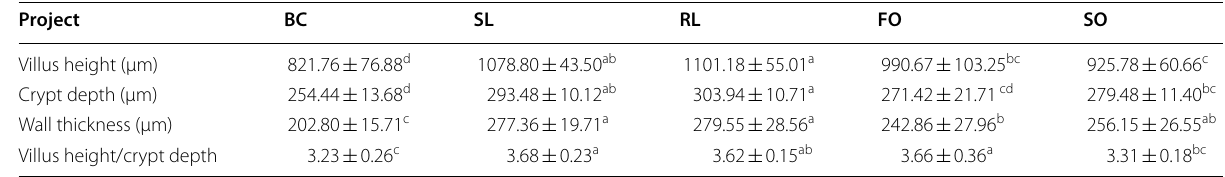
Table 2 Effect of dietary fat on the villus height, crypt depth and wall thickness of jejunum in rats